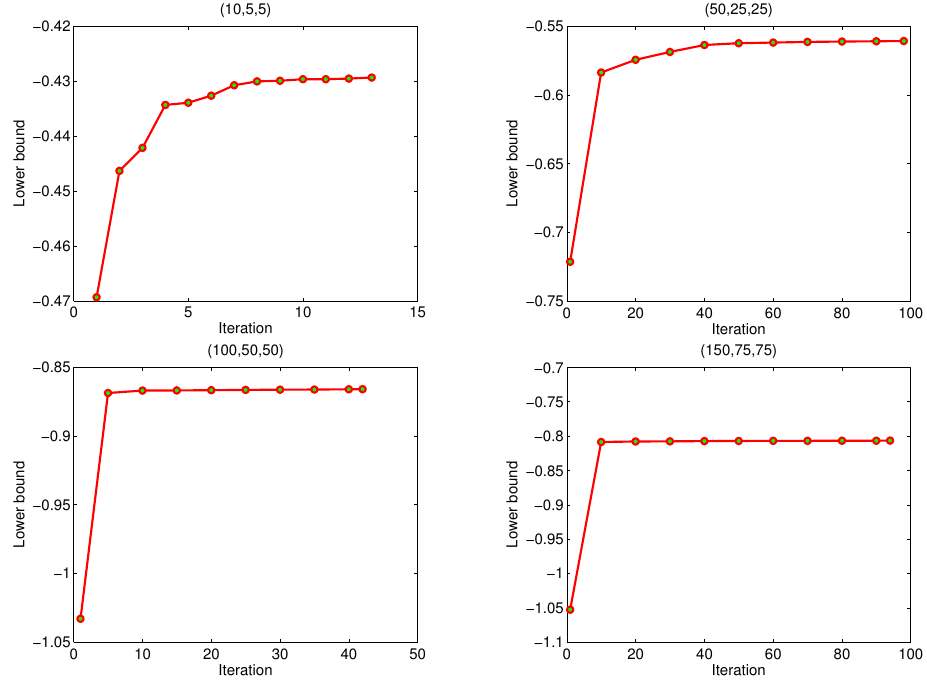
Figure 5. Convergence speed